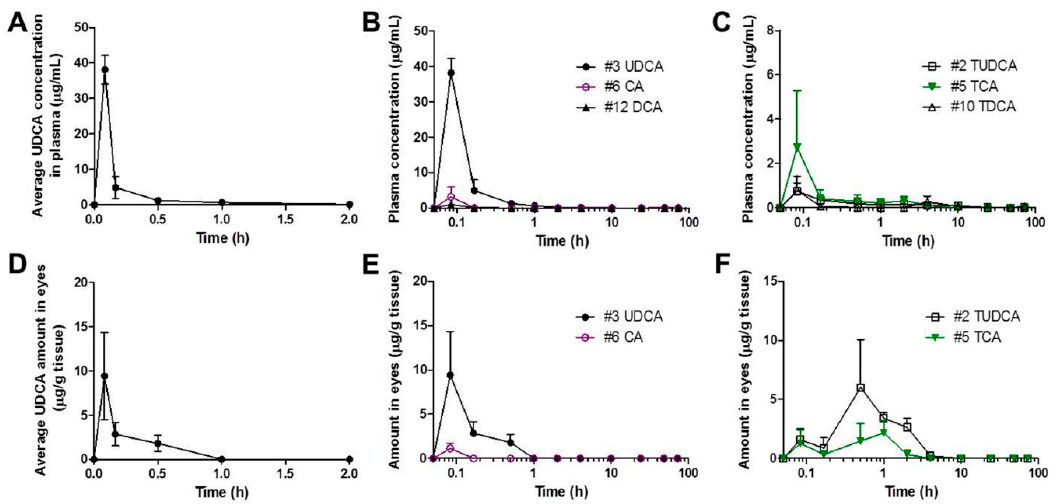
Figure 6. Average concentration of UDCA and its metabolic derivatives in the plasma or eyes after oral administration of YSB201 (125 mg / kg). ( A ) Average UDCA concentration ( µ g / mL) in plasma of the treatment group mice up to 2 h after YSB201 oral administration ( n = 3). Average concentrations of ( B ) unconjugated bile acids or ( C ) Taurine-conjugated bile acids in the plasma of the treatment group are displayed with the time in the logarithmic x -axis (0–72 h). Mean ± SEM ( n = 3). ( D ) Average UDCA amount (µg/g of tissues) in eye tissues of the treatment group mice up to 2 h after YSB201 oral administration ( n = 3). Average concentrations of ( E ) unconjugated bile acids or ( F ) Taurine-conjugated bile acids in the treatment group are displayed with the time in the logarithmic x -axis (0–72 h). The amounts of bile acids in the treatment group mice were calculated by subtracting the bile acid background signals of control mice ( n = 3) on the same diet as that of the treatment group mice ( n = 3). Table 4. The pharmacokinetic parameter values of mice plasma and eyes after oral administration of YSB201 (125 mg/kg) ( n = 3).